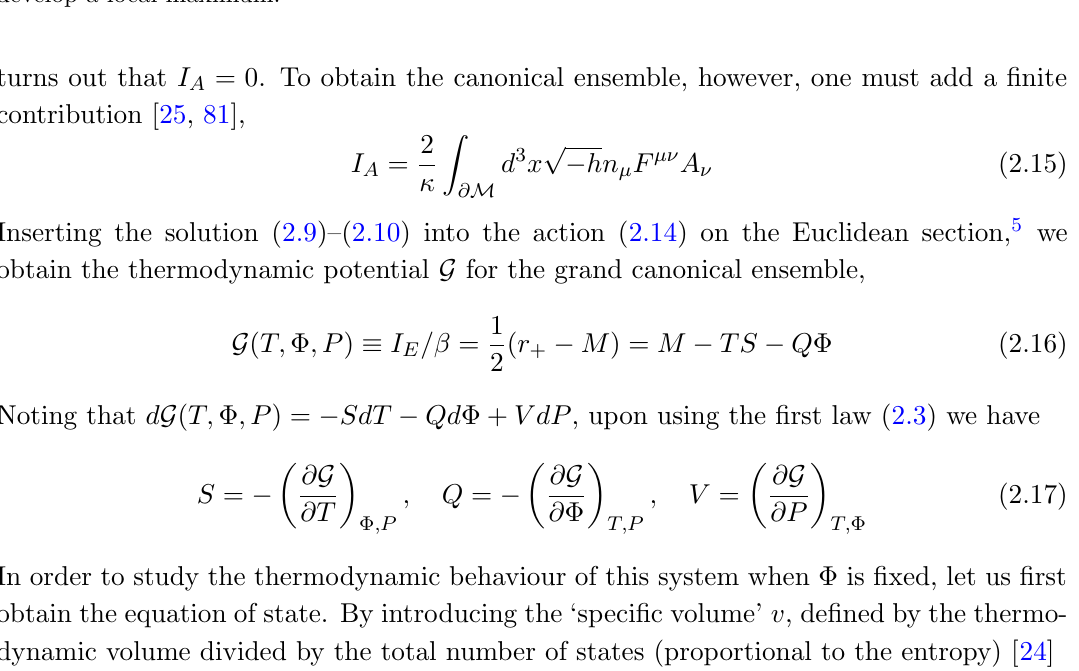
Figure 1 . Equation of state for (cid:8) = 0 (left), (cid:8) = 0 : 8 (middle) and (cid:8) = 1 (right). In the interval 0 (cid:20) (cid:8) < 1, the surface develops a maximum when T is (cid:12)xed. For (cid:8) > 1, the isotherms P - v do not develop a local